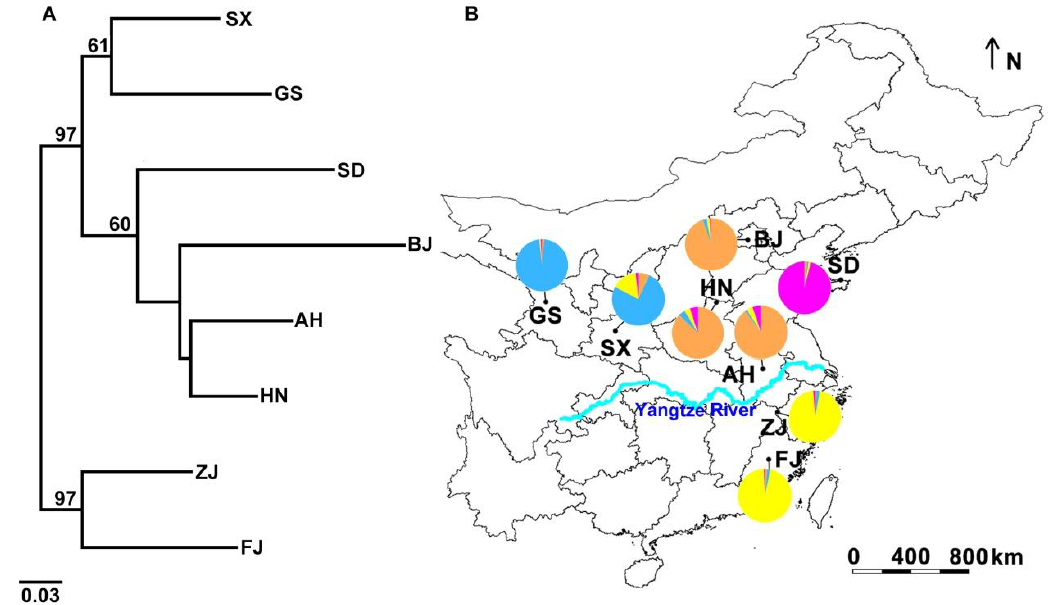
Figure 1. The distribution of eight Lycorma delicatula populations in China and the population structure analysis based on microsatellite markers. ( A ) The neighbor-joining tree was re-sampled with 1000 bootstraps, and the bootstrap values of more than 60 are given. ( B ) Population abbreviations are shown in Table 1; the proportion of populations from four clusters inferred by STRUCTURE analysis is shown in the pie charts; the map shows the distribution of the samples.The base map was obtained from URL: http://www.diva-gis.org/gdata. The brilliant blue line represents the Yangtze River.